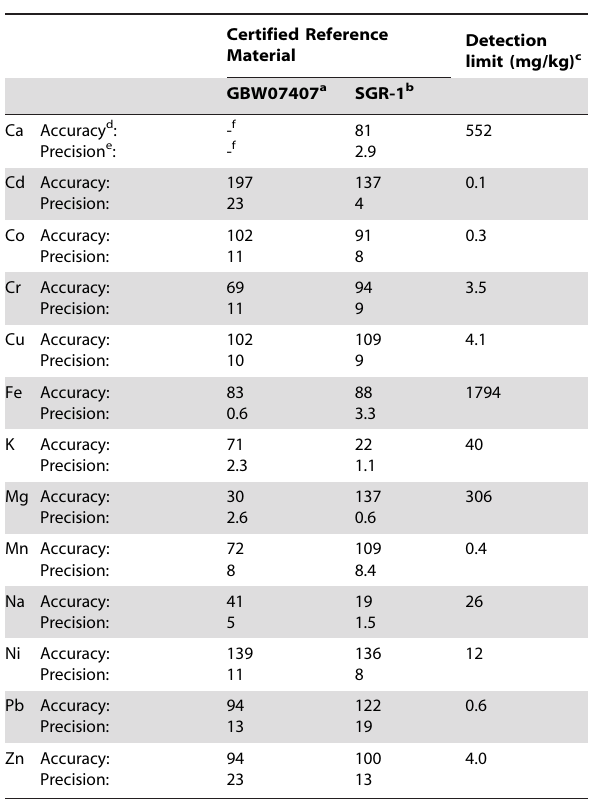
Table 1. Analytical accuracy, precision and detection limits determined from samples (CRMs; blanks) subjected to a nitric- perchloric acid digestion.